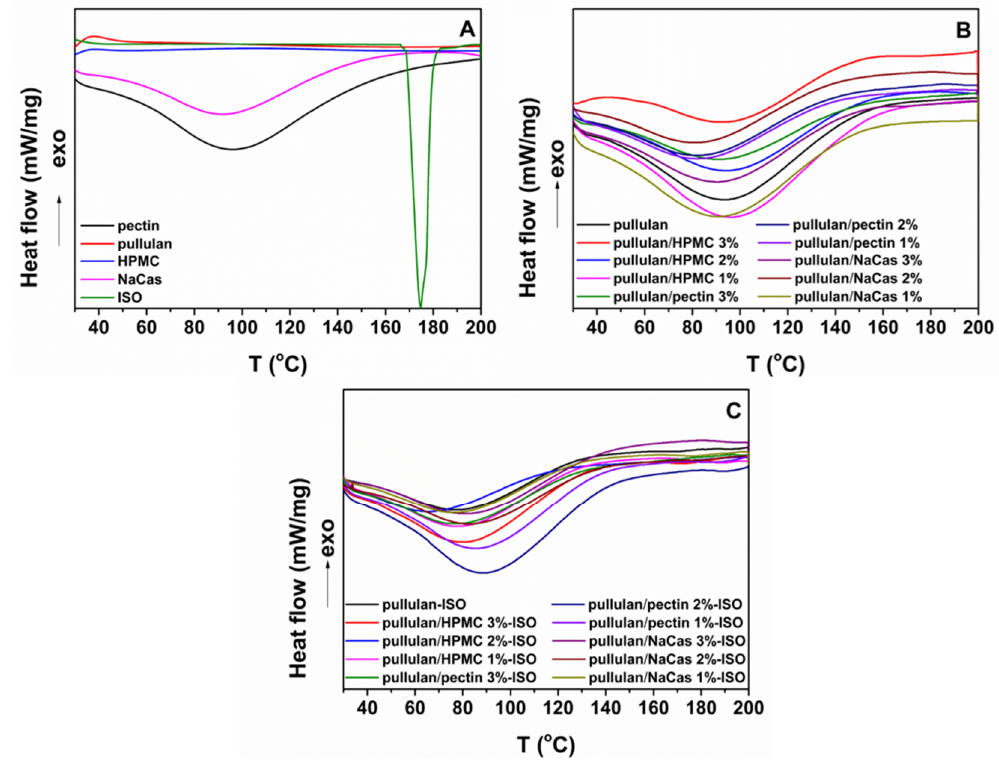
Figure 3. DSC thermograms of the ( A ) raw materials, ( B ) plain ODFs and ( C ) ISO-loaded ODFs.